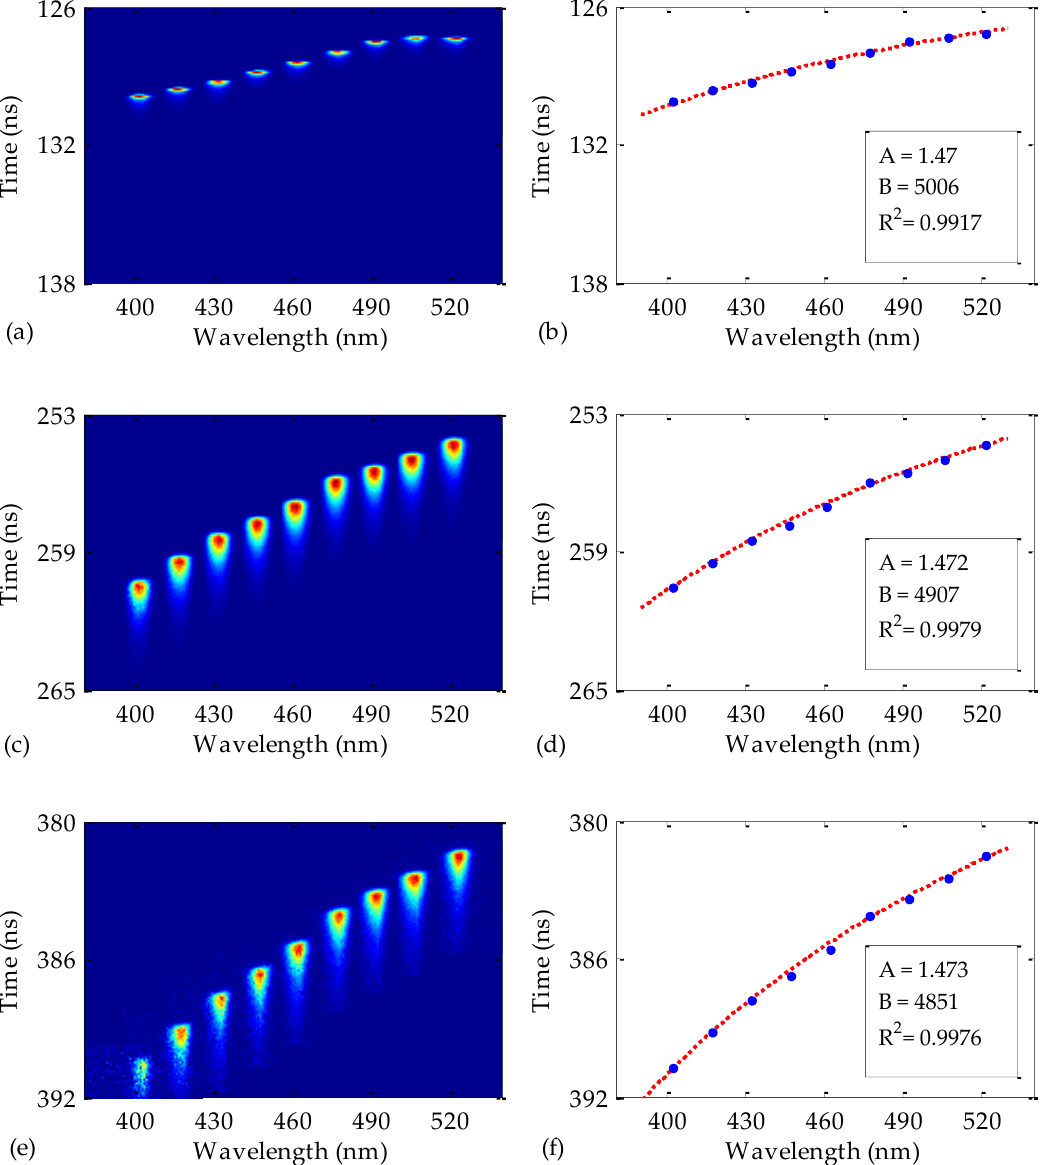
Figure 3. ( a , c , e ): Streak images of the output pulses measured from Toray fibers whose lengths are 25, 50, and 75 m, respectively. ( b , d , f ): corresponding instants of maximum pulse intensity together with the fittings to Equation (3). The insets show the resulting constants and the corresponding coefficients of determination of the fittings.